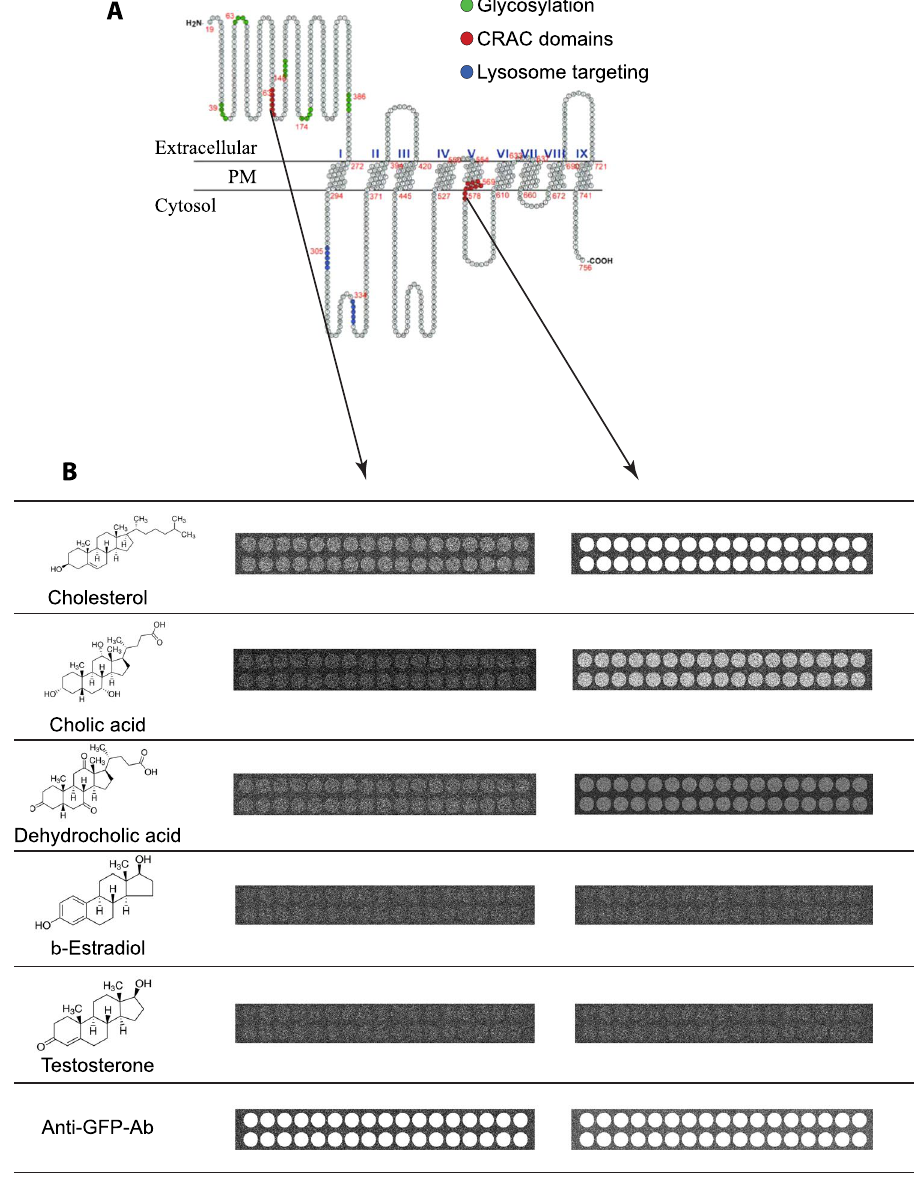
Figure 6. Sterol microarrays suggest that the transmembrane CRAC domain from SIDT1 binds several sterols. ( A ) Cartoon illustrating the putative secondary structure of SIDT1. The nine putative transmembrane domains are shown. In red are mark the amino acids forming the two CRAC domains and in blue a putative lysosome localization signal (not explored in the present study). ( B ) TIRFM-based microarray studies illustrating the spots containing the following sterols tested: cholesterol, cholic acid, dehydrocholic acid, β -estradiol and testosterone. As positive control, some spots in the microarray were printed with an anti-GFP antibody (lower panels). Each microarray contained 2 lines of 17 spots each. The fluorescence illustrated represents the binding of the fusion protein formed by the CRAC domain attached to GFP. For CRAC domain sequences, please refer to Material and Methods. Notice that the extracellular CRAC domain did not bind any of the sterols tested while the transmembrane CRAC domain binds to cholesterol and only weakly to cholic acid. Both fusion proteins bind strongly to the anti-GFP